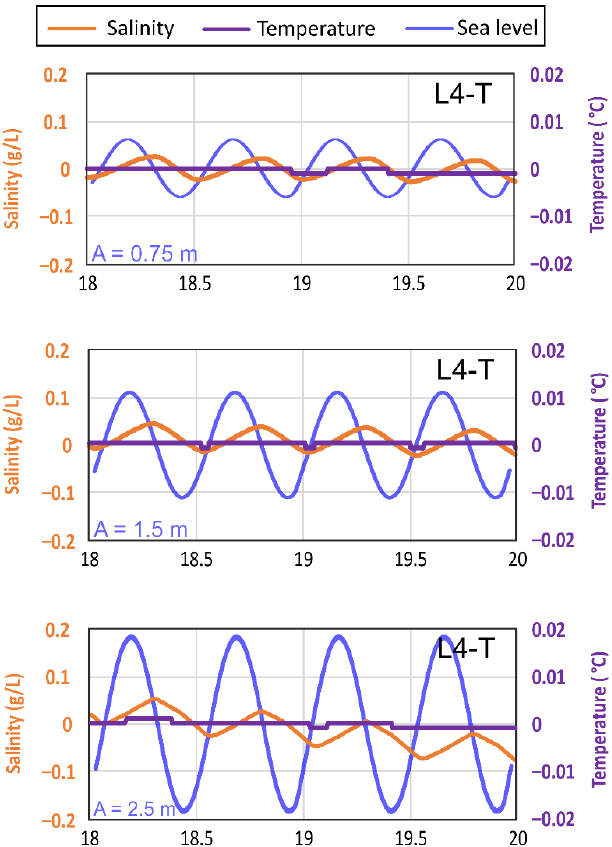
Figure 9. Simulation results of the homogeneous model (Model A) for microtidal, mesotidal, and macrotidal conditions (semi-amplitudes of 0.75 m, 1.5 m, and 2.5 m, respectively) measured at the observation point L4-T.